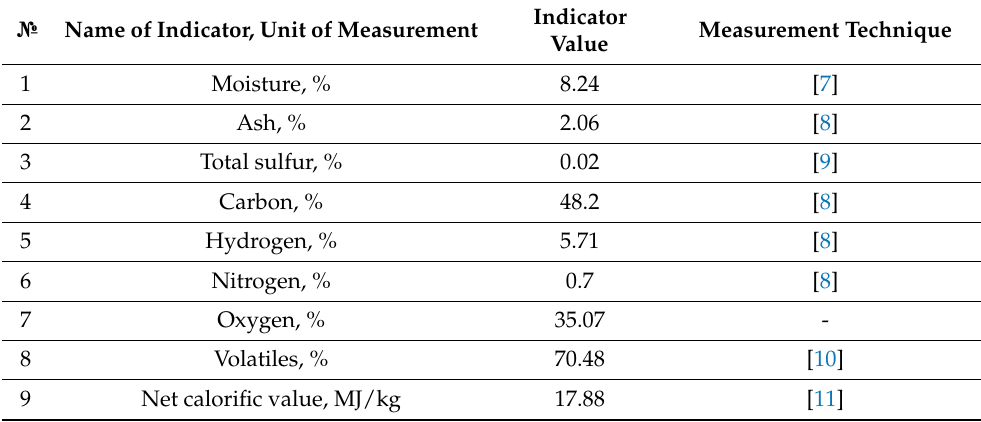
Table 1. Characteristics of sunflower husk pellets (on a dry basis). № № Name of Indicator, Unit of Measurement Indicator Value